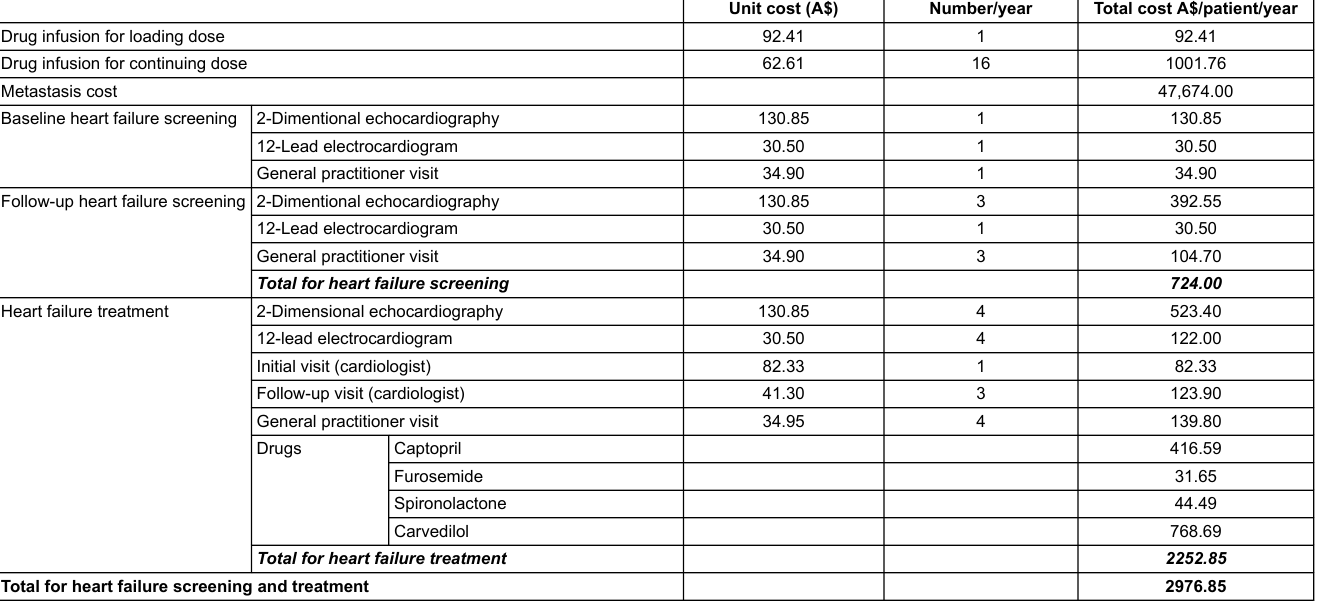
Table 4: Costs of trastuzumab infusion, heart failure screening and treatment and